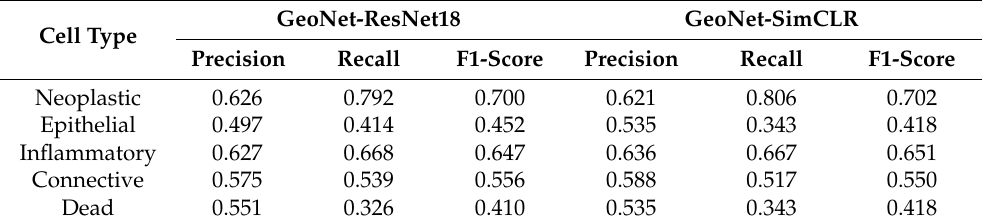
Figure 10. Different types of cell instances in LUSC (the first row) with their classification saliency maps (the second row). ( a , b ) are negative cells and ( c , d ) are positive cells. Table 1. Numerical detection results for unlabelled images in the PanNuke data set.